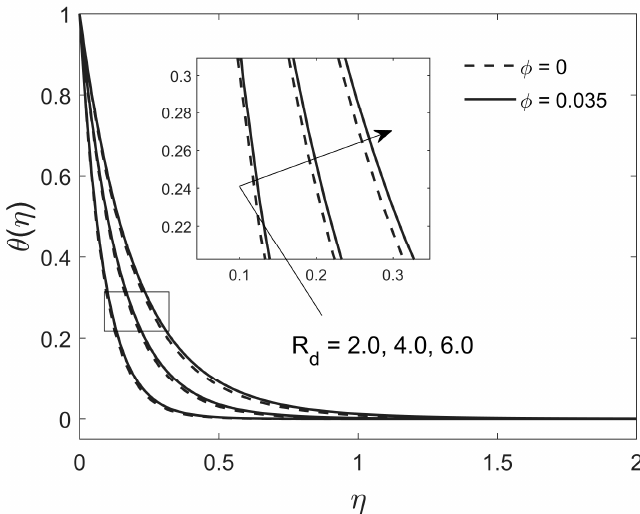
Figure 14. Effect of radiation on the temperature distribution.